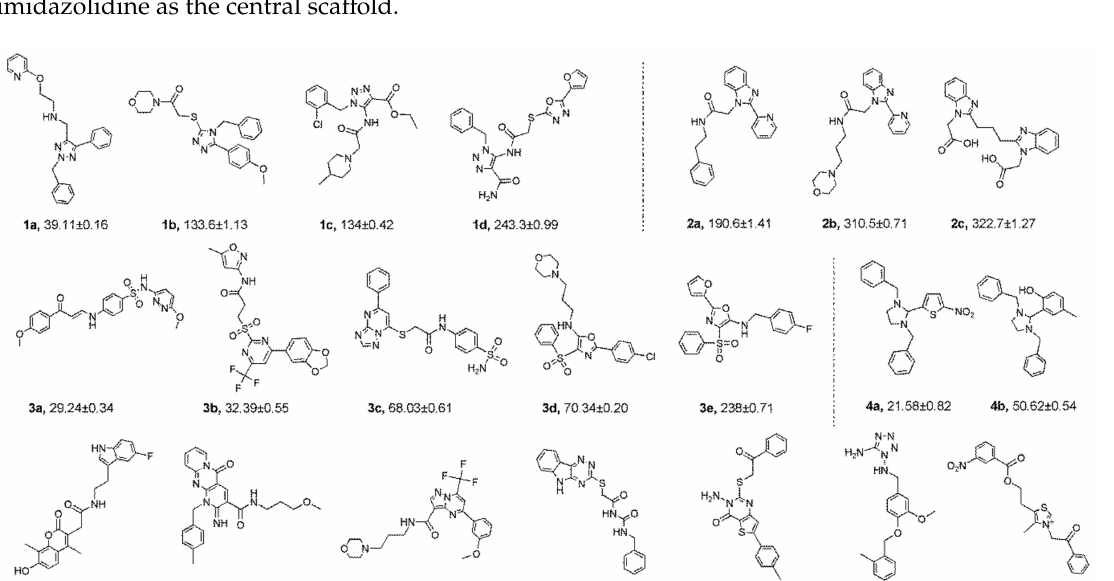
Figure 3. Chemical structures and anti-proliferative activity (IC 50 = the mean ± SD µ M, n = 3) against MCF-7 cells of the top 21 molecules identified from the virtual screening (positive control: 17-AAG, IC 50 = 7.18 ± 0.13 µ